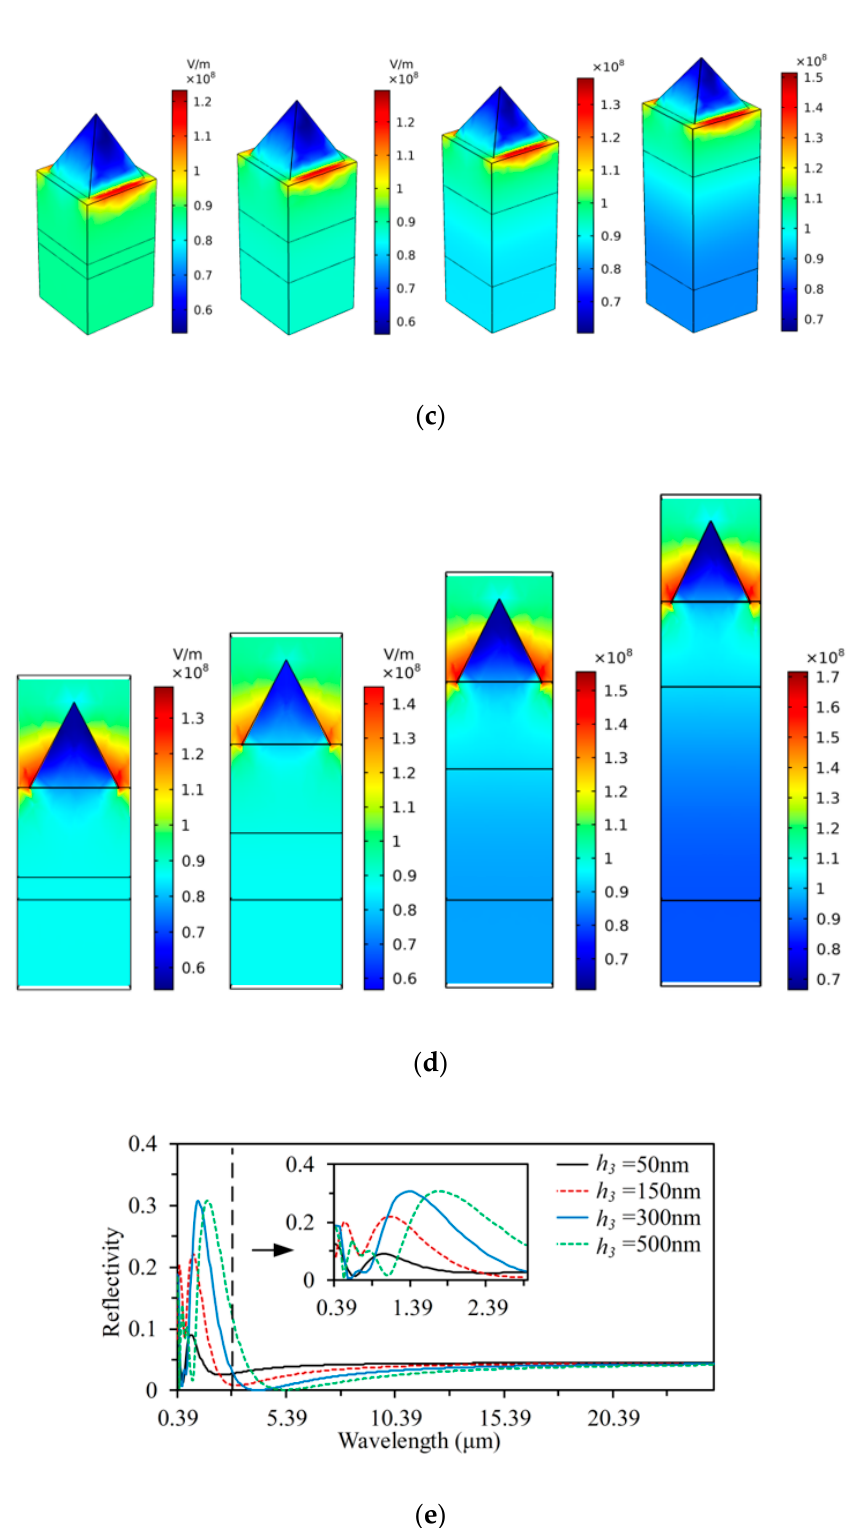
Figure 5. Numerical results of spectral characteristics of pyramidal biomimetic micro-nano structures as a function of air gap. Images of three-dimensional and central cross-sectional distributions of the electrical field intensity for the pyramidal micro-nano structures with a variety of air gaps (50, 150, 300, and 500 nm) under the wavelength of 1.54 µ m ( a , b ) and 5.99 µ m ( c , d ), respectively. ( e ) Spectral reflectance curves of pyramidal biomimetic micro-nano structures modulated by air gap, indicating that an increase of air gap can decrease the solar absorptance and increase the infrared emissivity.